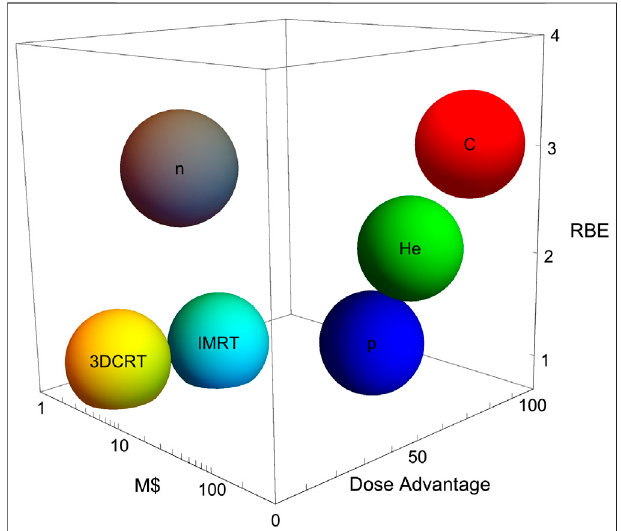
FIGURE 6 | The cost-effectiveness of particle therapy. The plot shows physical advantages (dose, in an arbitrary scale), biological advantages (RBE, in a realistic clinic scale), and cost in millions $ for 3D conformal radiotherapy (3DCRT), intensity modulated radiotherapy (IMRT), neutrons and three charged particles (protons, helium, and